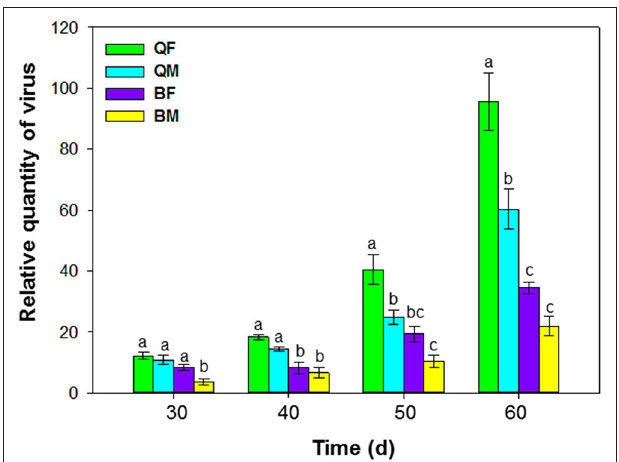
FIGURE 3 | Accumulation of tomato chlorosis virus in tomato following transmission by B. tabaci MEAM1 and MED. QF, MED females; QM, MED males; BF, MEAM1 females; BM, MEAM1 males. The Y axis values refer to the relative quantity of virus detected in the two youngest leaves of each replicate plant. Values are means ± SE. For each time, means with different letters are significantly different ( P < 0.05; N = 10).